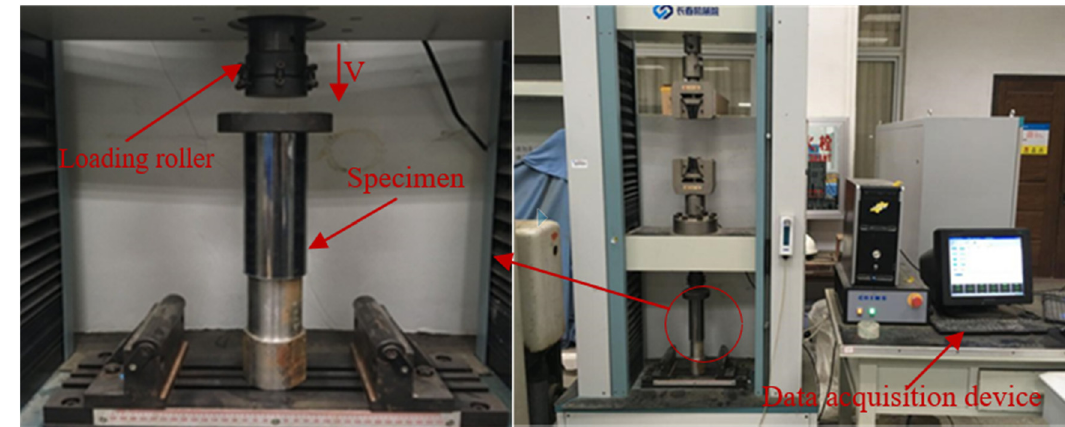
Figure 14: Interference fi t joint assembly measurement